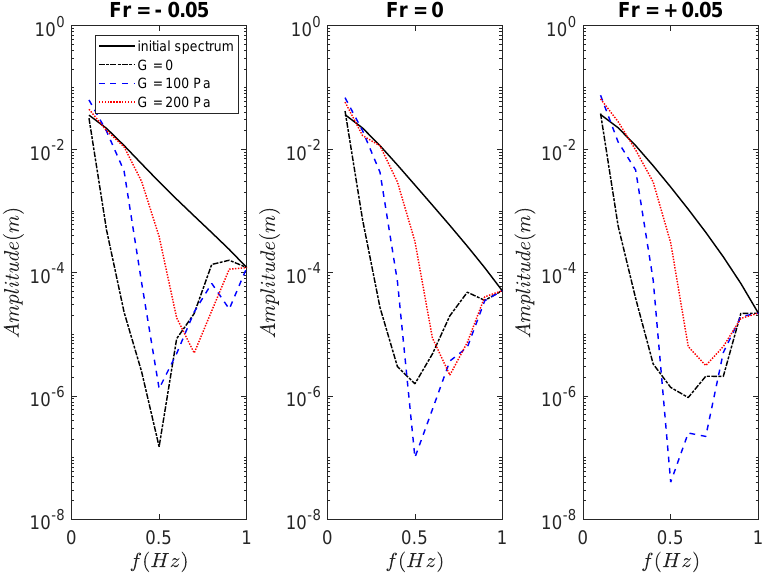
Figure 8. Evolution of a cnoidal wave spectrum with subharmonic interactions deactivated. Wave and mud parameters and water depth are the same as those in Figure